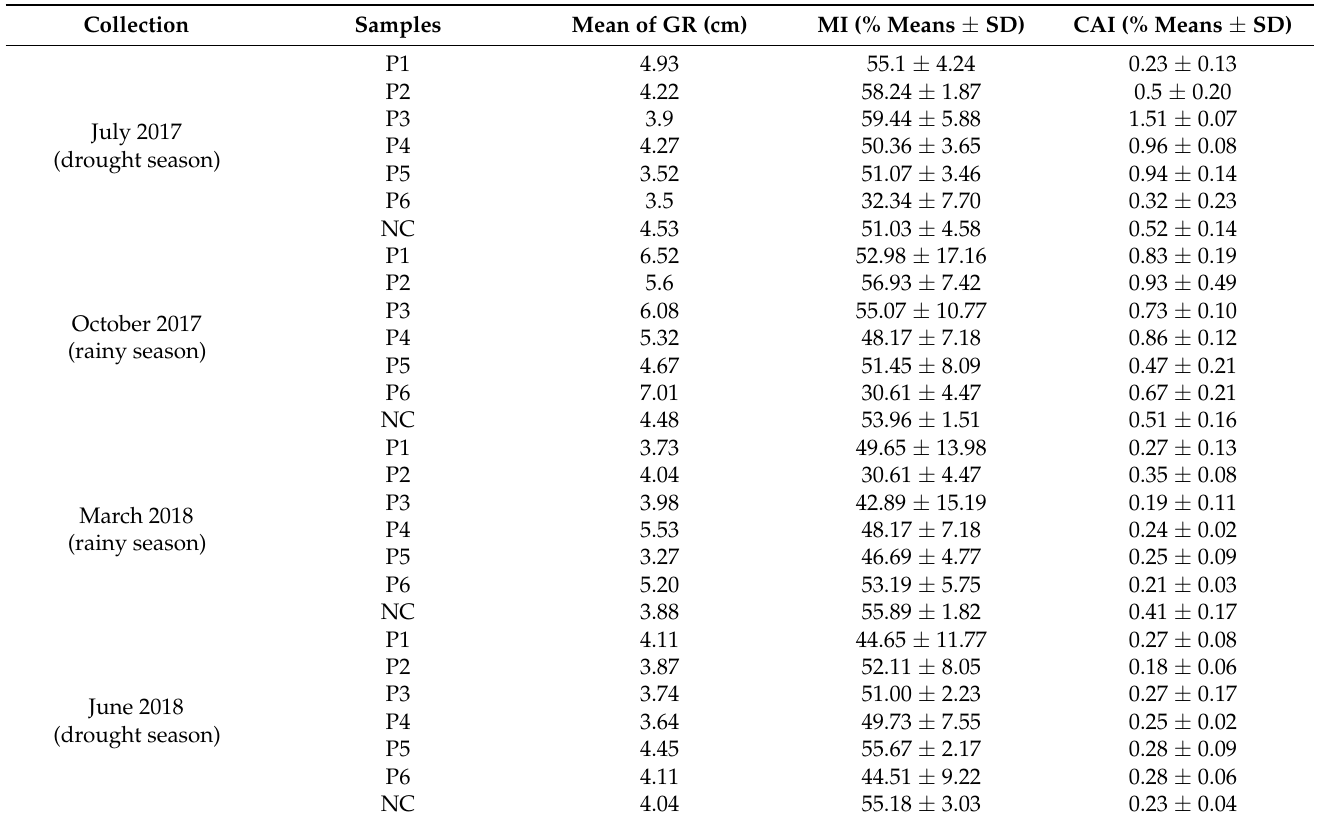
Table 5. Characterization of mutagenicity and cytotoxicity of water samples from Buritis Lake by the A. cepa